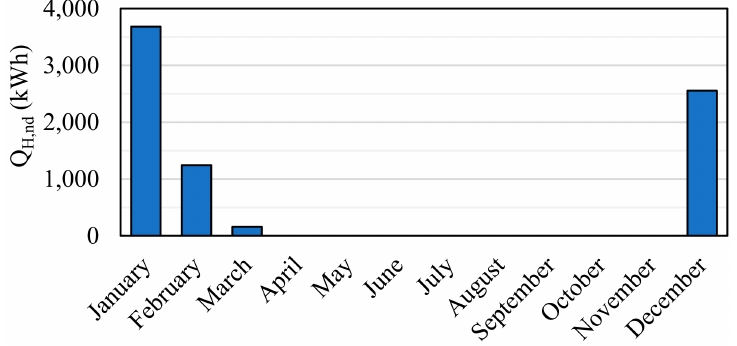
Figure 10. Monthly distribution of energy needed for heating Q H;nd